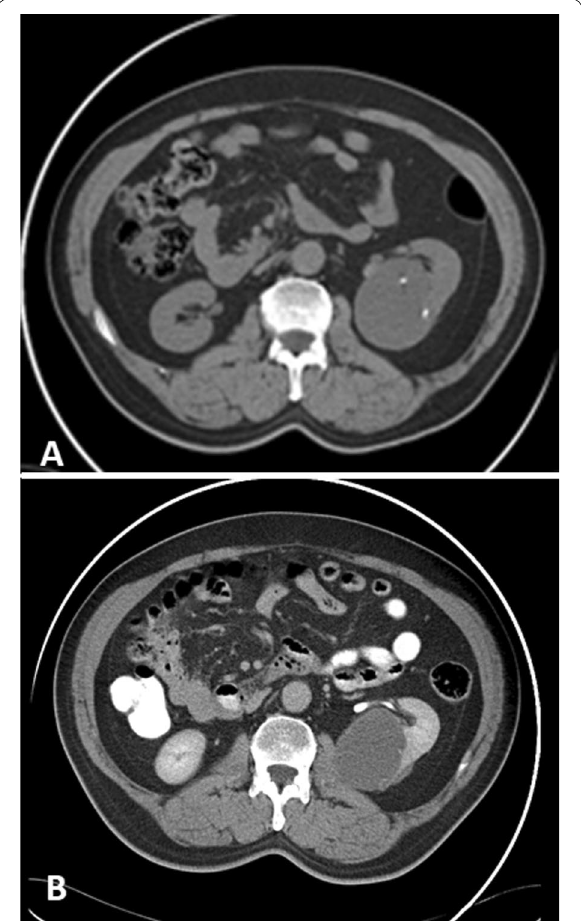
Fig. 1 An unenhanced axial CT scan shows a well-defined low-attenuated mass compatible with a cyst. Renal cyst calcification is depicted ( A ). Axial enhanced CT scan in the excretory phase shows no delayed internal enhancement and no association with the pyelocalyceal system. External pressure on the pyelocalyceal system without invasion is noted ( B